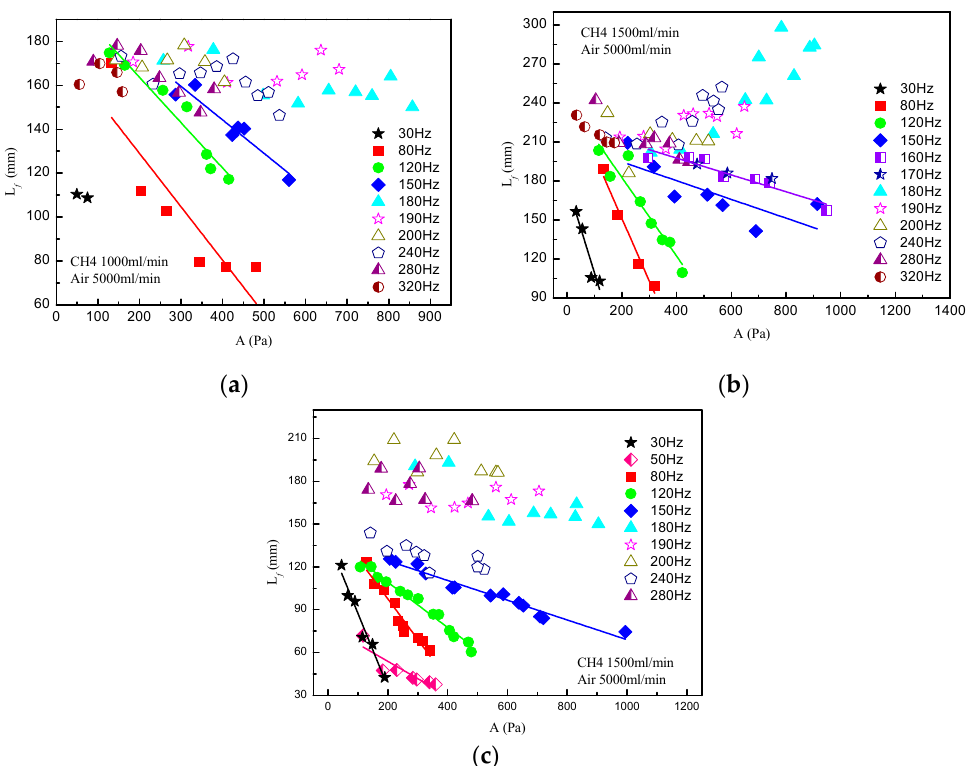
Case 3 Case 3 ( c ) Case